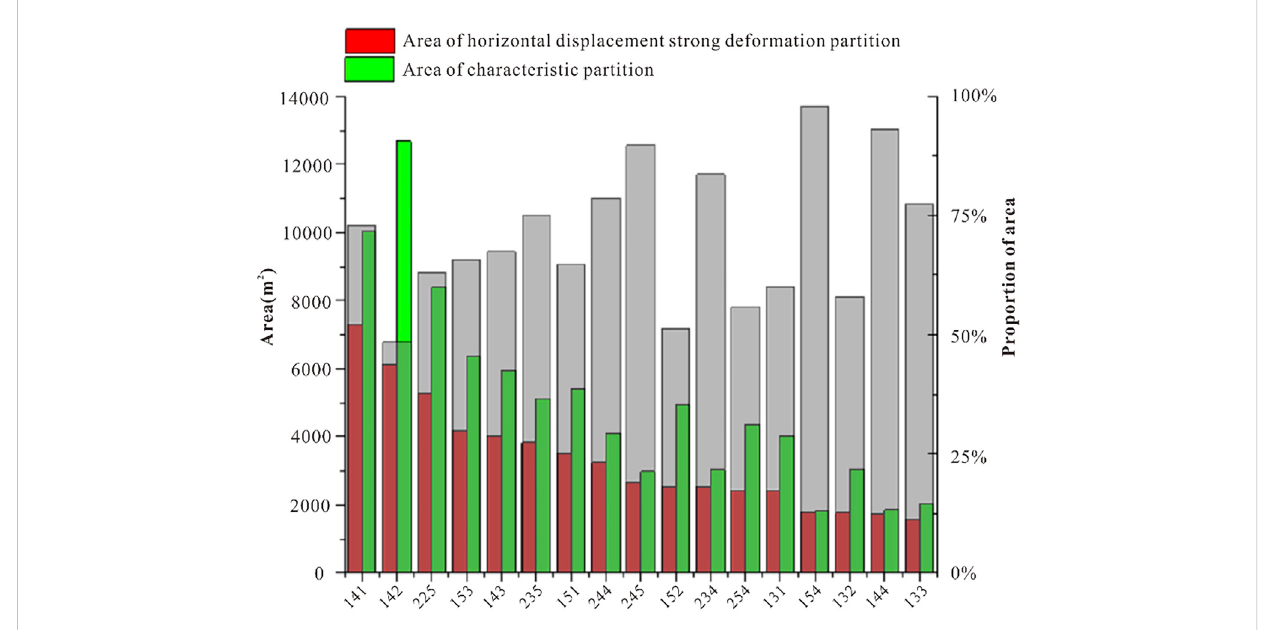
FIGURE 14 The ratio of the area of strong deformation of horizontal displacement and its characteristic area.